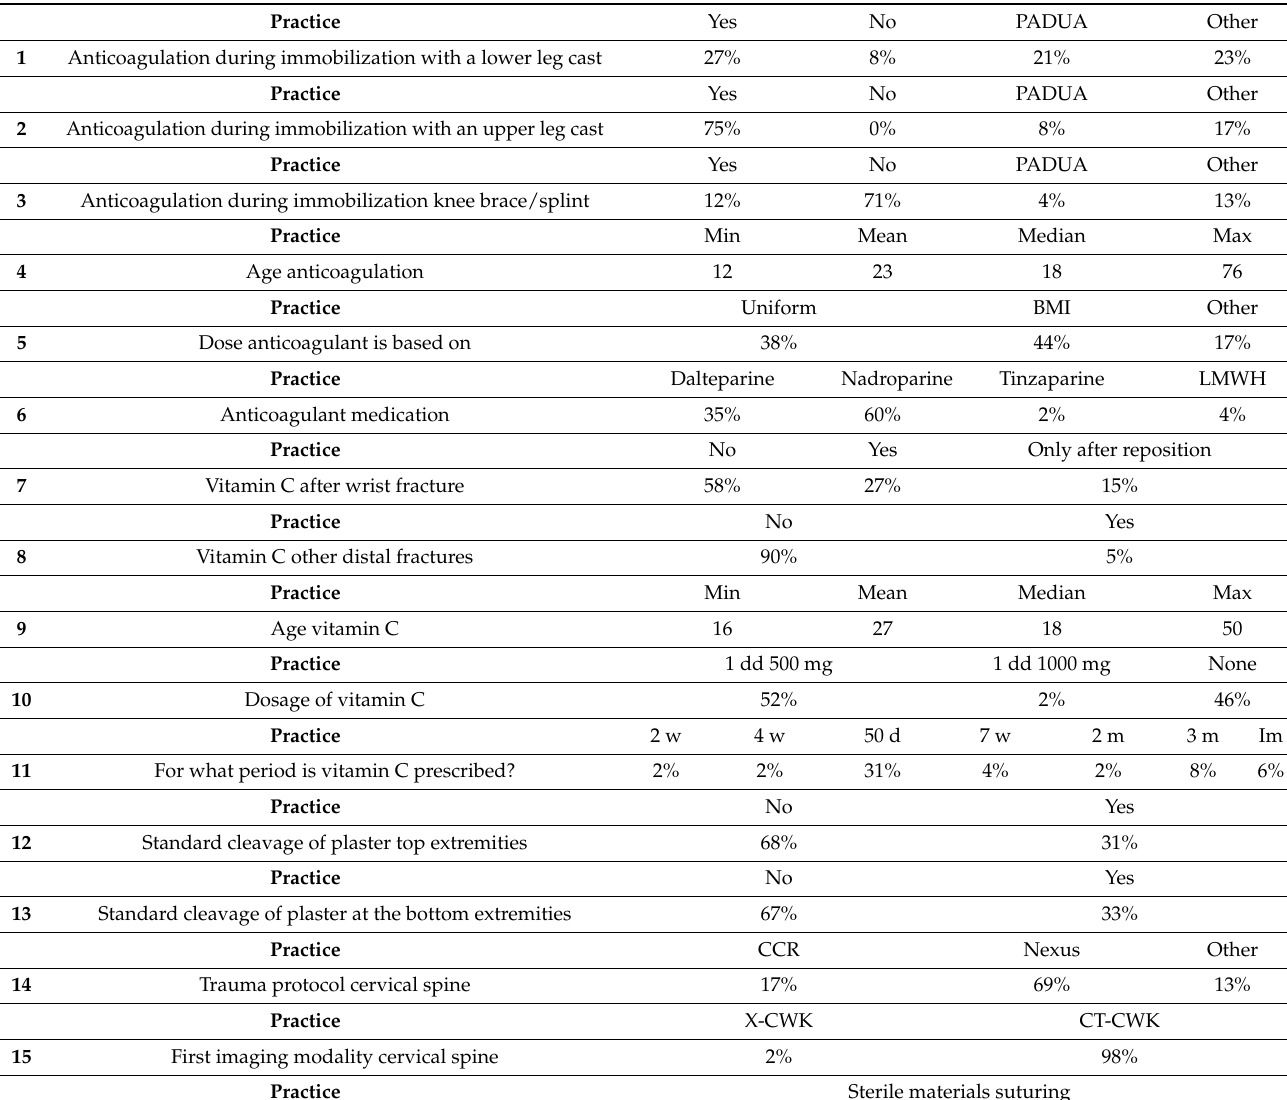
Table 2. Results of